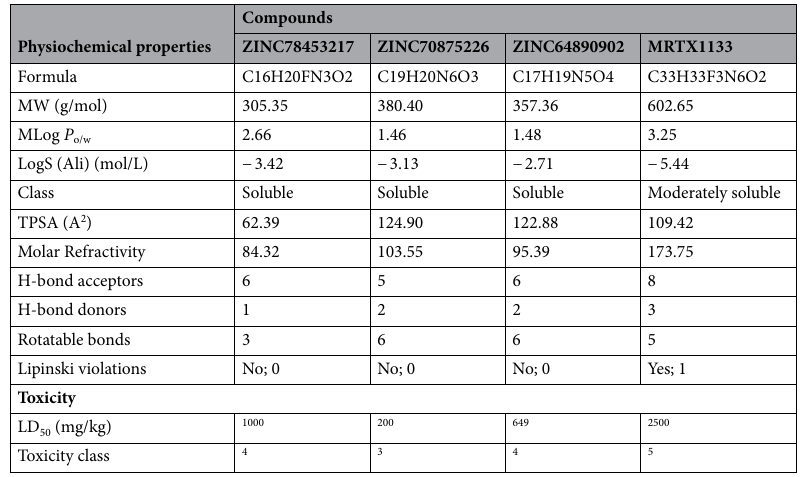
Table 4. Physiochemical properties of the top 3 hit compounds relative to MRTX1133. a HBD = number of hydrogen bond donors (HBD ≤ 5); HBA = number of hydrogen bond donors (HBD ≤ 10); TPSA = total polar surface area; MLOGP = predicted octanol/water partition coefficient (MLOGP < 4.15); MW = molecular weight (g/mol) (MW ≤ 500); Rotatable bonds ≤ 8; TPSA = Topological polar surface area (≤